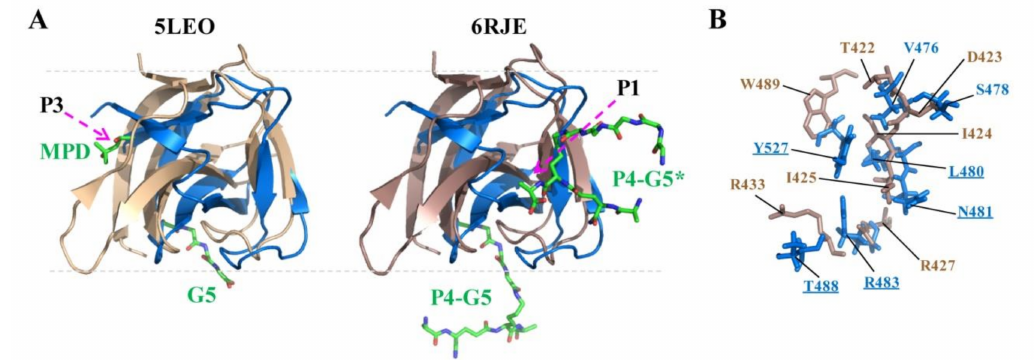
Figure 5. Structure comparison of CpAcp SH3b6 with lysostaphin SH3b. ( A ) Superposition of the structure of CpAcp SH3b6 (marine) with those of lysostaphin SH3b bound by different ligands with PDB IDs of 5LEO (wheat) and 4RJE (dark salmon). The bound ligands are shown as sticks and labeled with green font. MPD, (4S)-2-methyl-2,4-pentanediol; G5, pentaglycine; P4–G5 and P4–G5*, A γ QK[GGGGG]A peptide. The positions for P1 and P3 pockets of CpAcp SH3b6 are marked with dashed arrows. ( B ) The residues in the binding site of lysostaphin SH3b for P4–G5* and the corresponding residues of CpAcp SH3b6 P1 are shown as sticks and colored in dark salmon and marine, respectively.